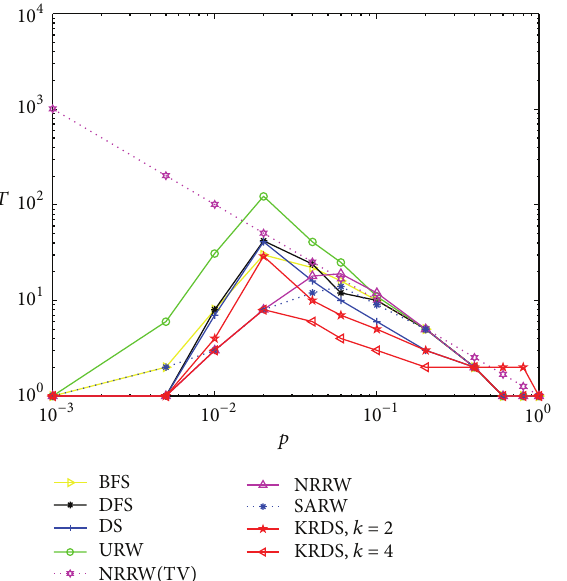
Figure 5: Plot of the average number 𝑇 of search steps versus the network size 𝑁 of the WSSWN with connection probability 𝑝 = 0.3